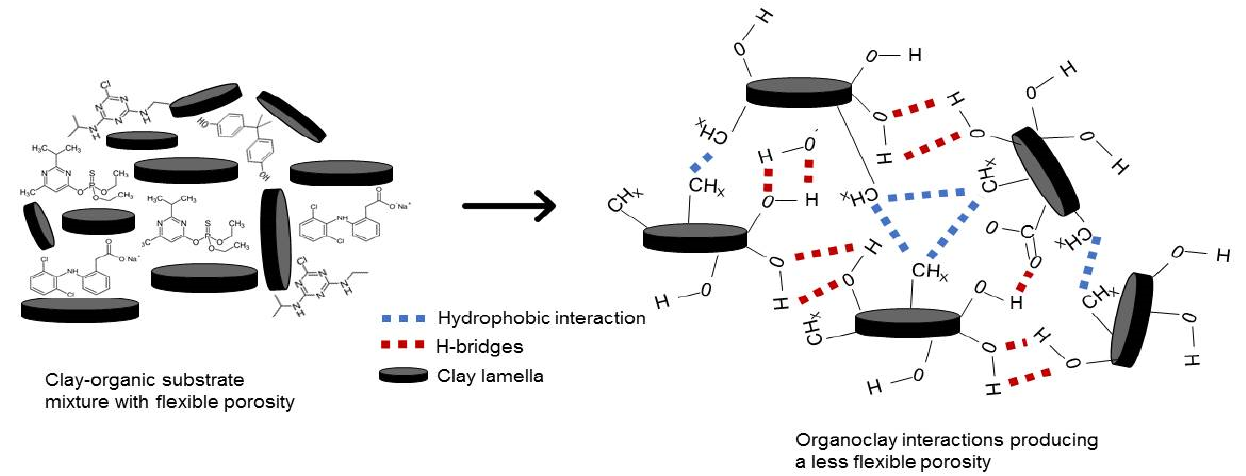
Scheme 1. Diffusion of molecular species in clay and possible interactions. Table 3. Kinetic parameters of the intra-particle diffusion model for the adsorption of the organic substrate on Fe(II)Mt and HMt-1.